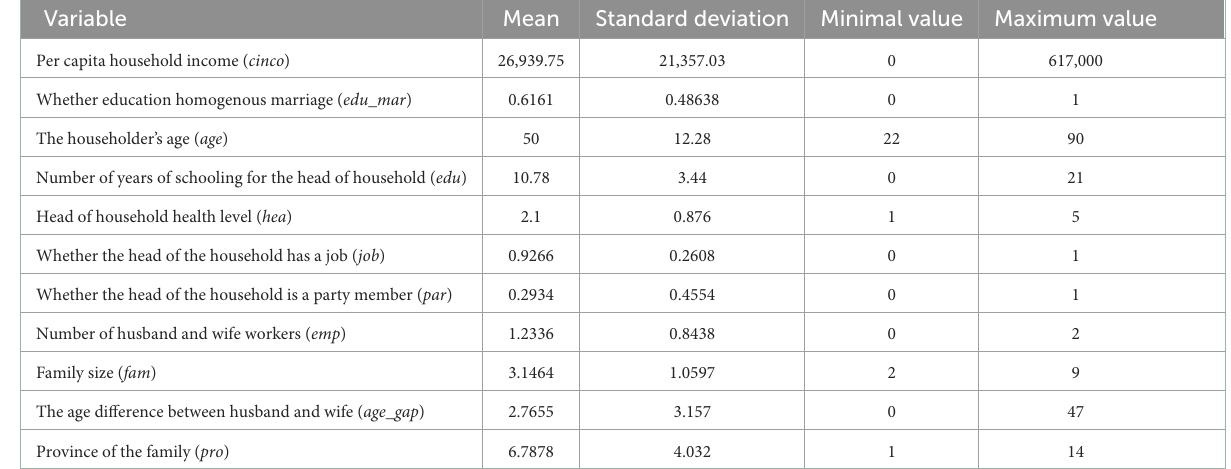
TABLE 1 Descriptive statistical